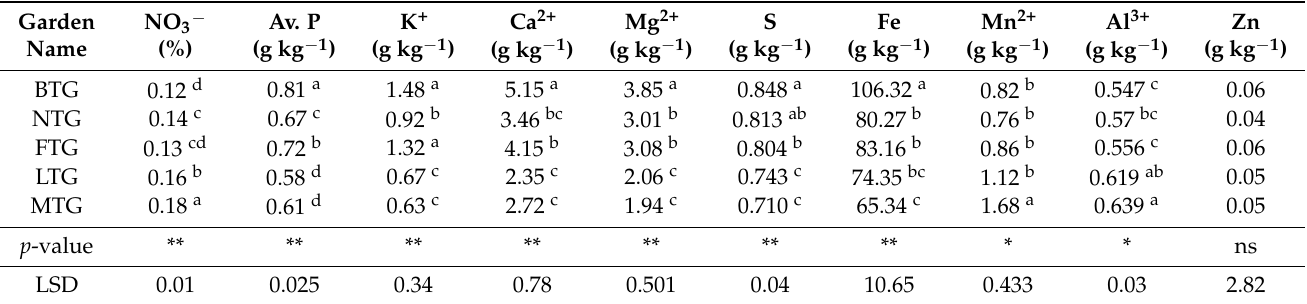
Table 1. Effect of traditional fertilization on nutrient availability of tea garden soil. Values are means ( n = 3). Values containing same letters are statistically similar. ** = Significant at 1% level ( p < 0.01), * = Significant at 5% level ( p < 0.05), ns = nonsignificant.